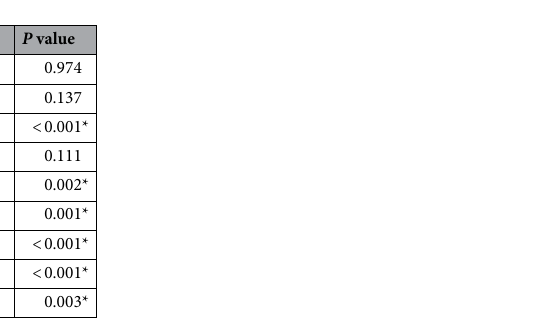
Table 3. Logistic regression for associated factors to the presence of right-angled vessel. ELM external limiting membrane, EZ ellipsoid zone, IDZ interdigitation zone, ONL outer nuclear layer. * P values < 0.05 by logistic regression